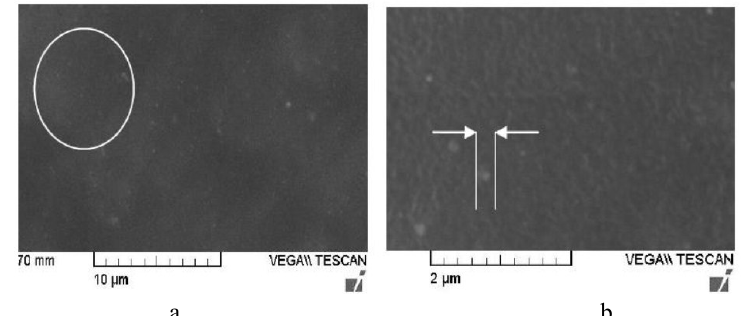
Figure 8. SEM photographs of cryogenically fractured surface of NRS20 sample: (a) 5.0 kx; (b) 25.0